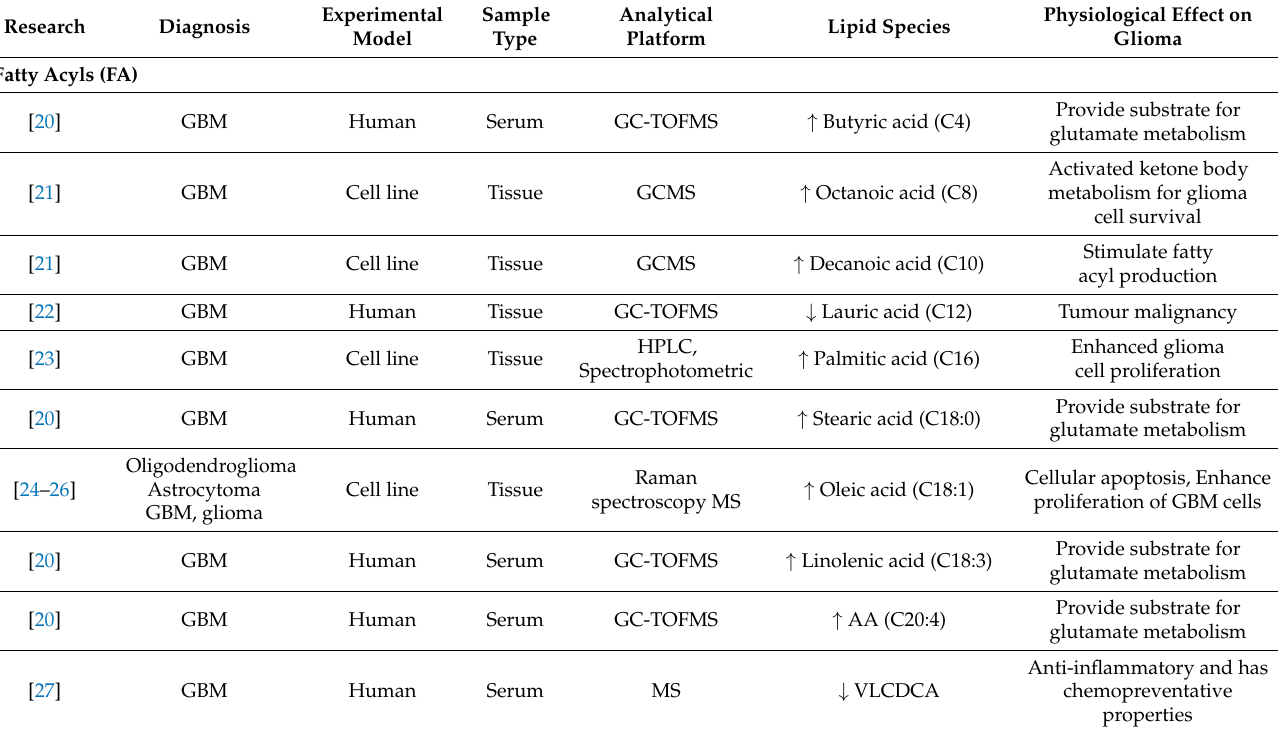
Figure 4. A collective of prominent lipids metabolite from lipid classes with properties of carcinogenic and anticarcinogenic roles in glioma. (Refer to Supplementary Table S3 for the abbreviation). Table 1. Carcinogenic roles of lipid in